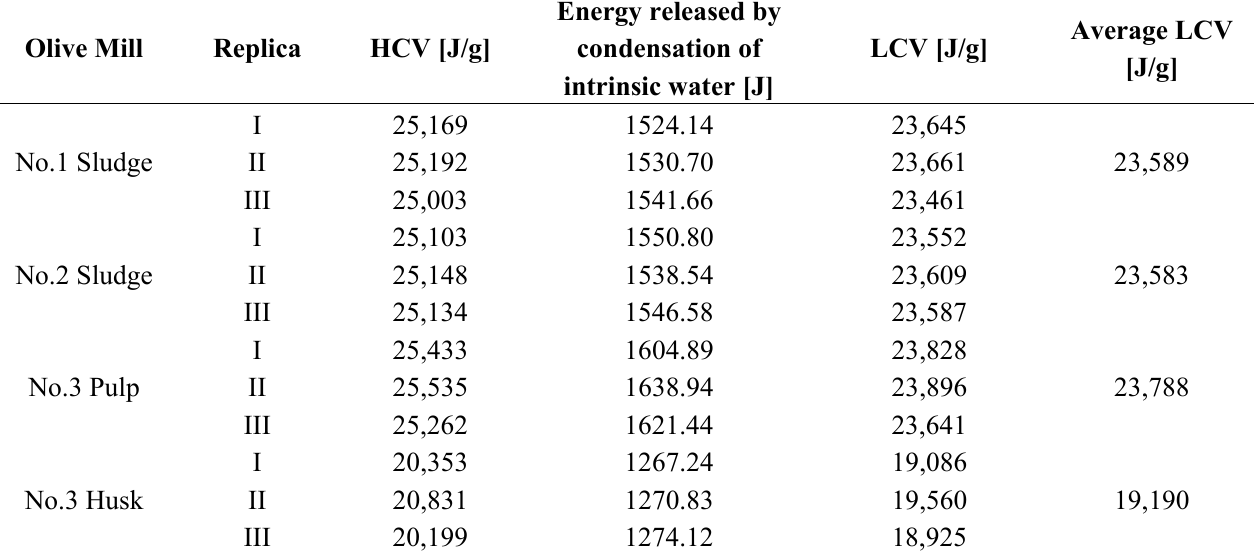
Table 7. Calculation of LCV.